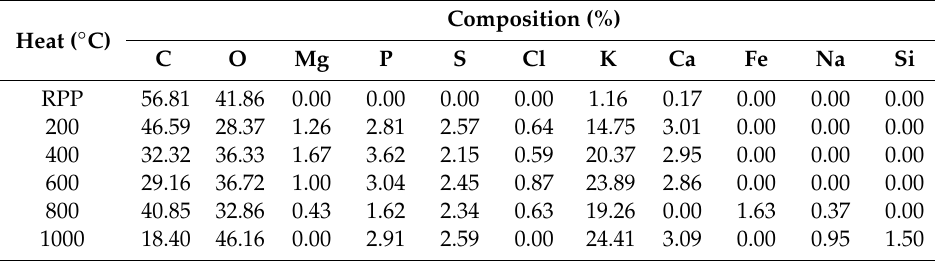
Table 2. EDX analysis results of CPP.